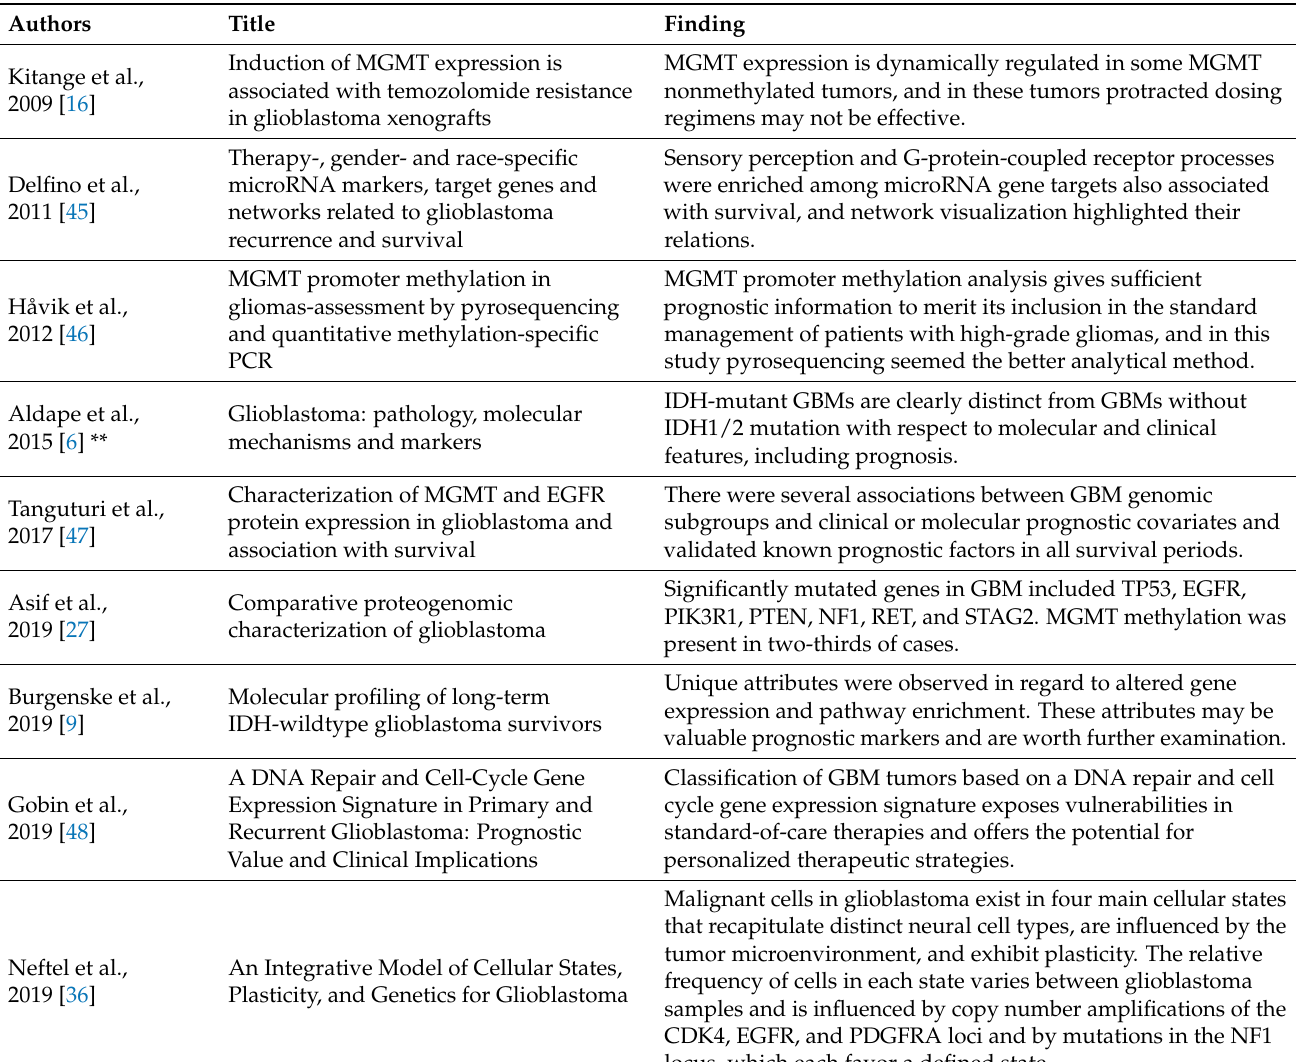
Table 1. Relevant studies in Glioma. ** Denotes major literature review on the